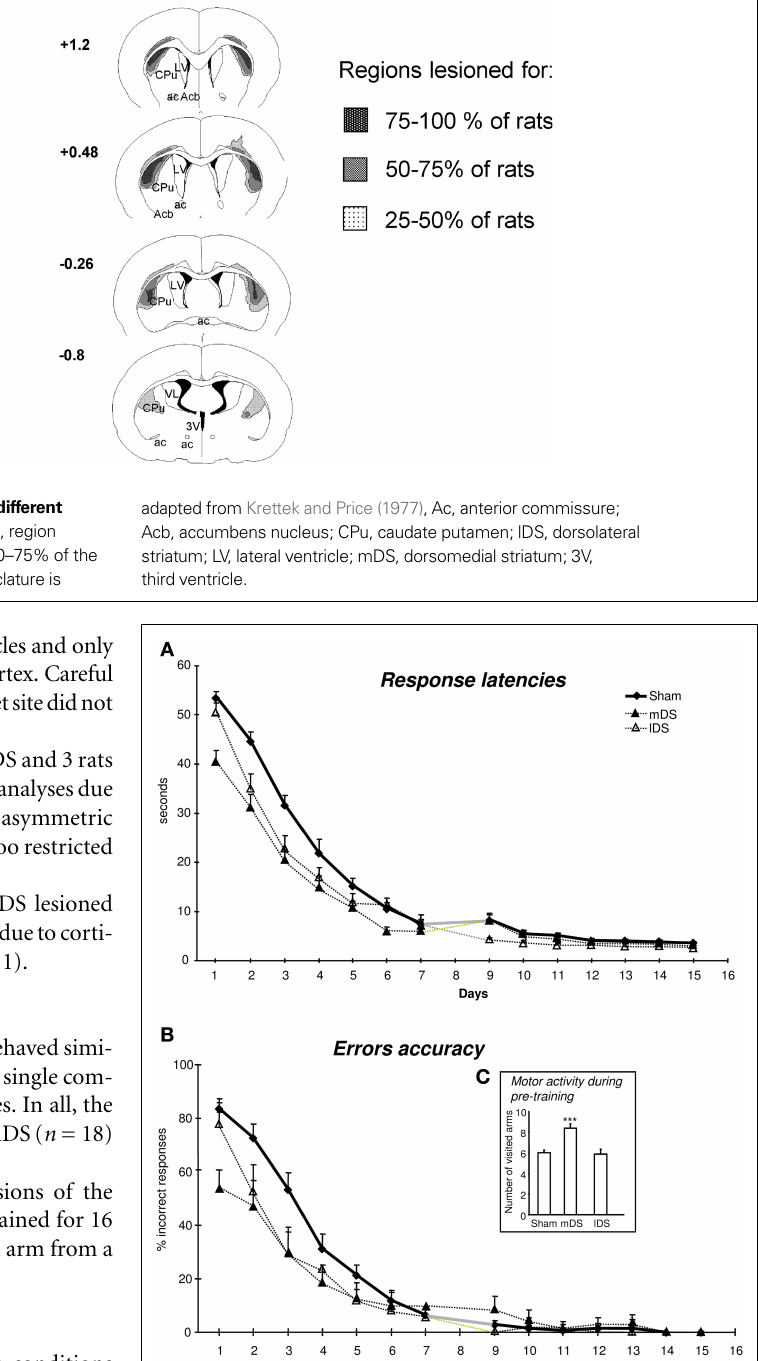
FIGURE 2 | Performance across 15 days of acquisition training in the cross- maze. (A) Group means of response latencies (sec ± SEM). (B) Group means of percent errors ( ± SEM) in Sham, mDS and lDS-lesioned rats. (C) Group means of arms visited during pre-training ( ± SEM) in sham, mDS- and lDS-lesioned